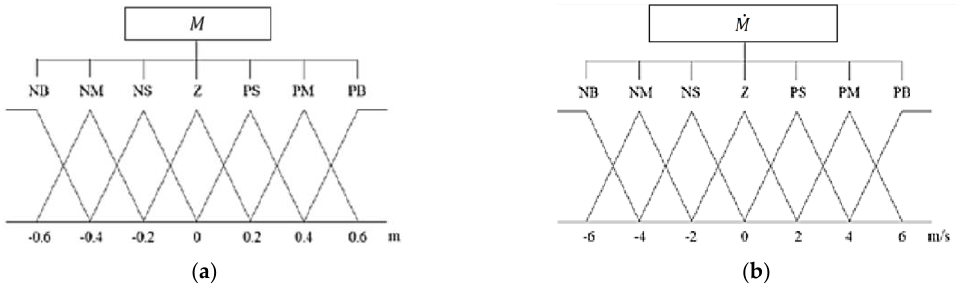
Figure 10. Membership functions of fuzzy logical control (FLC)-Input: ( a ) Language variable architecture of M ; ( b ) Language variable architecture of M .